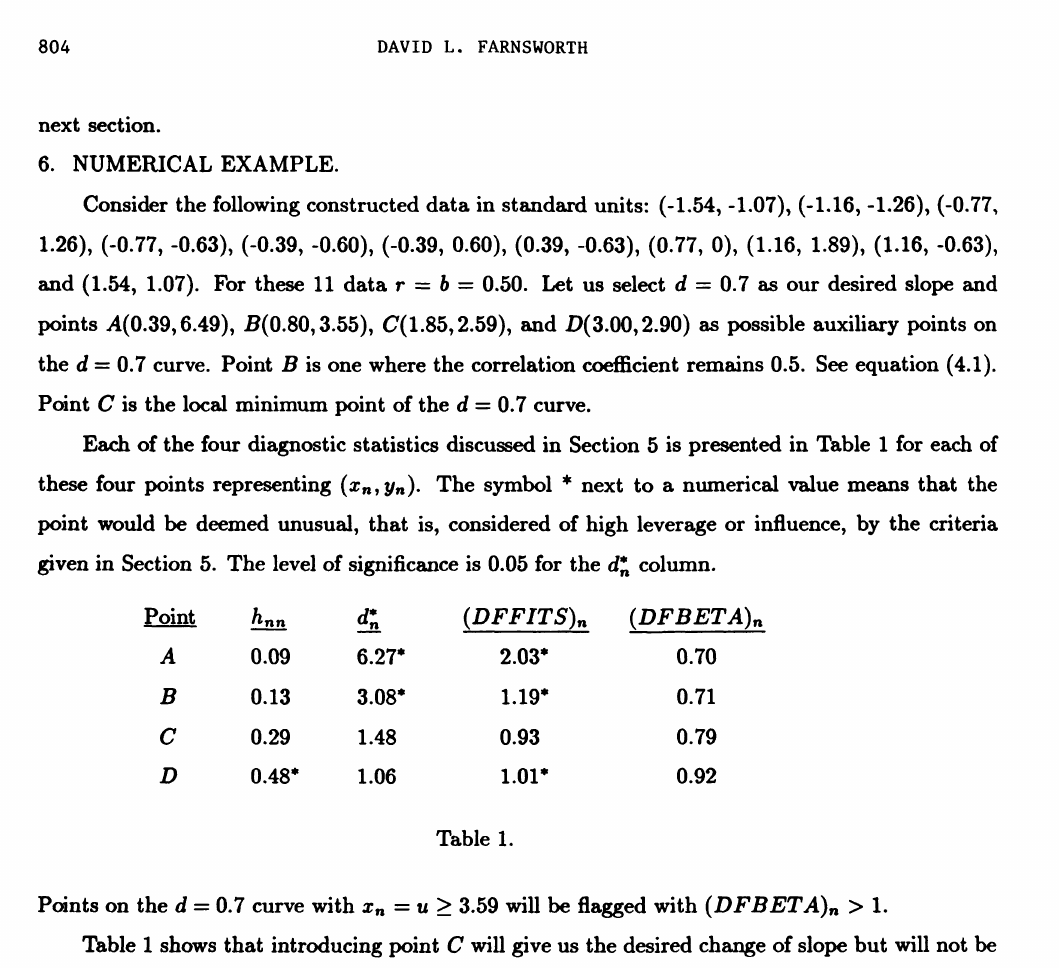
Points on the d 0.7 curve with